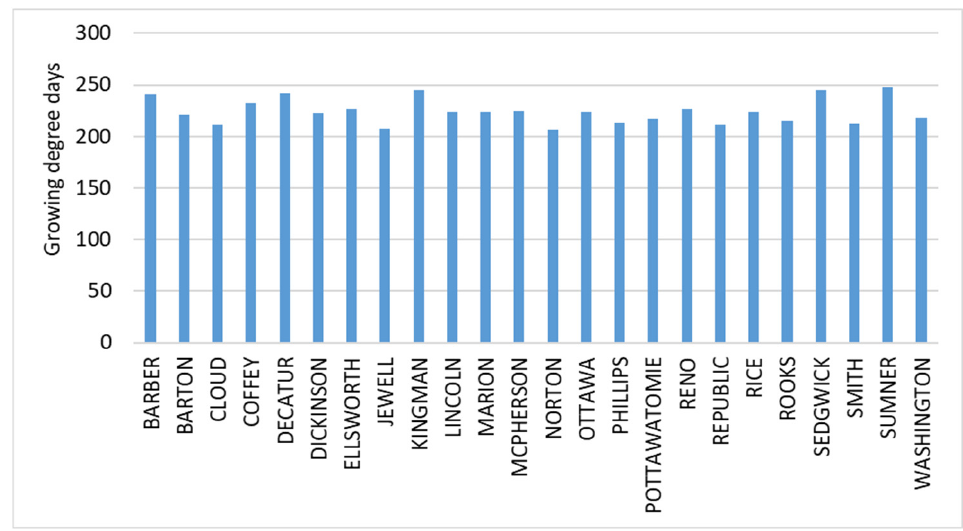
Figure 4. The number of alfalfa growing degree days in a year, estimated using 30 yrs (1988–2017) daily maximum and minimum temperature of each county and the alfalfa base temperature (5 °C).